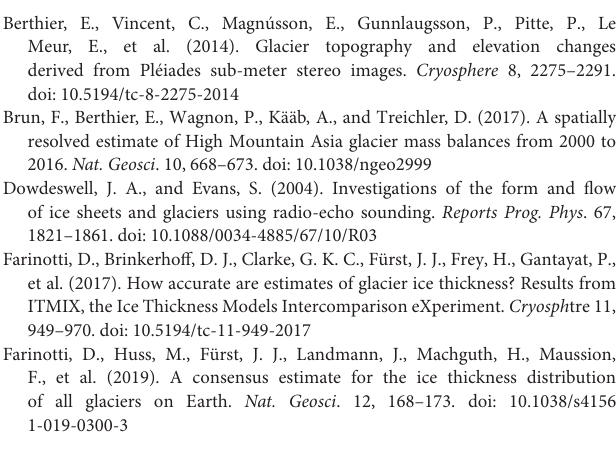
Figure S1 | Imagery used in this study. (a) SPOT 7 satellite image acquired 20 August 2016. The location of Elbrus is shown by the red box and the location of Djankuat glacier is shown by the blue box. (b) Mosaic of aerial images obtained during the aerial survey of Elbrus glaciers 8 September 1997. (c) Pléiades image acquired 8 September 2017. Figure S2 | Single spherical semivariogramm model for the DEM1997 and DEM2017 difference over the stable terrain. Figure S3 | Elbrus glacier volume distributions with elevation in 1997 and 2017, together with average annual elevation change values for 100m elevation bins. Glaciers arranged according to their aspect. Figure S4 | (a) Area and (b) surface elevation changes in the western sector of Elbrus. The elevation increase on glacier N316 ∗ is marked by an arrow. Table S1 | List of corrections made to the 1997 DEM and standard deviations ( σ ) of 1 h values over the stable